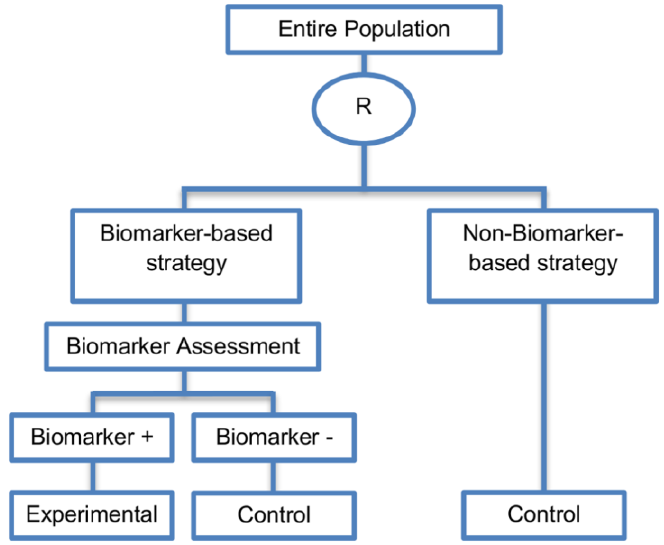
Figure 13. Biomarker-strategy design without biomarker assessment in the control arm. “R” refers to randomization of patients.